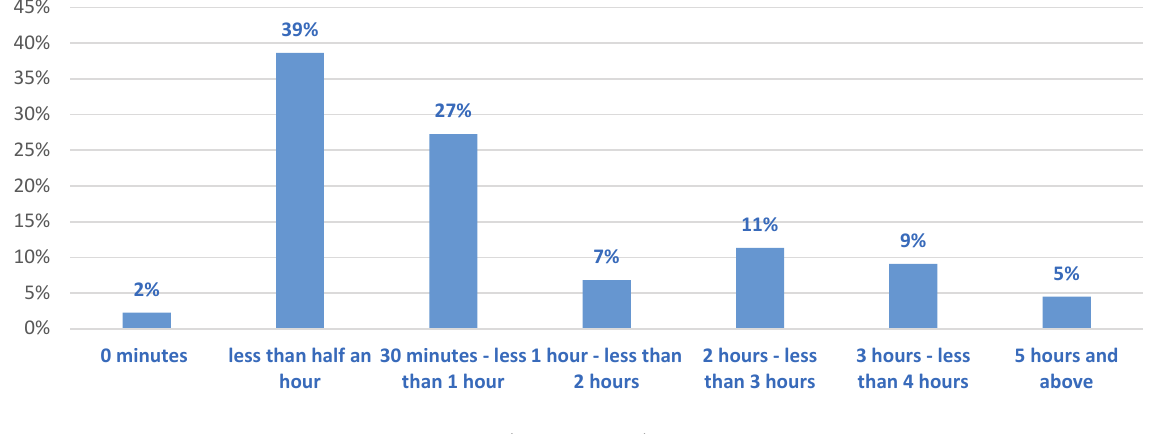
Fig. 4. Time spent on the